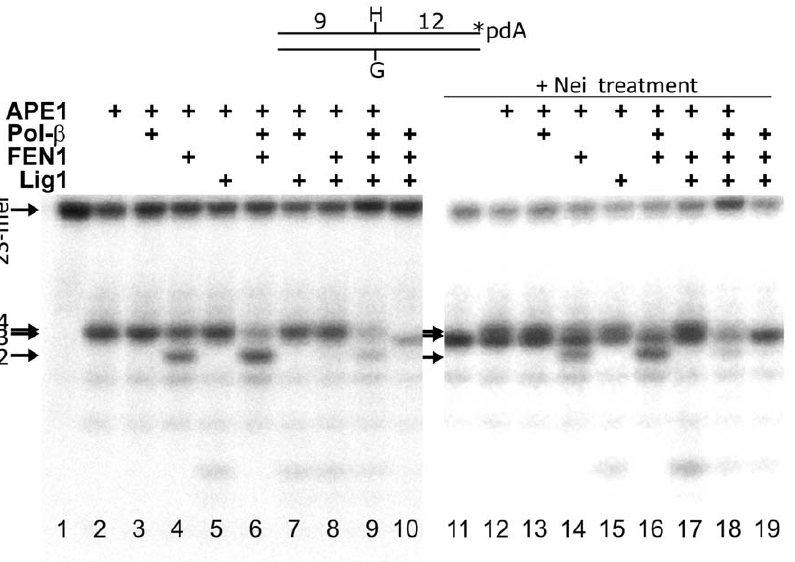
Figure 4. Invitro reconstitution of the long-patch NIR pathway using 5-OH-Hyd N G duplex DNA substrate. 3 9 -[ a - 32 P]-ddATP-labelled 5OH-Hyd N G oligonucleotide duplex was incubated with human proteins in the reaction buffer for 1 h at 37 u C. Lanes 1–10, reconstitution reactions in the presence of indicated proteins; lanes 11–20, same as 1–10 but treated with Nei. The arrows denote the position of the 23-mer, 14-mer, 13-mer and 12-mer fragments. Note that ‘‘23-mer’’ denotes the position of both the 3 9 -[ 32 P]-labelled 5OH-Hyd N G substrate and repaired C N G oligonucleotide duplex. For details see Materials and Methods.